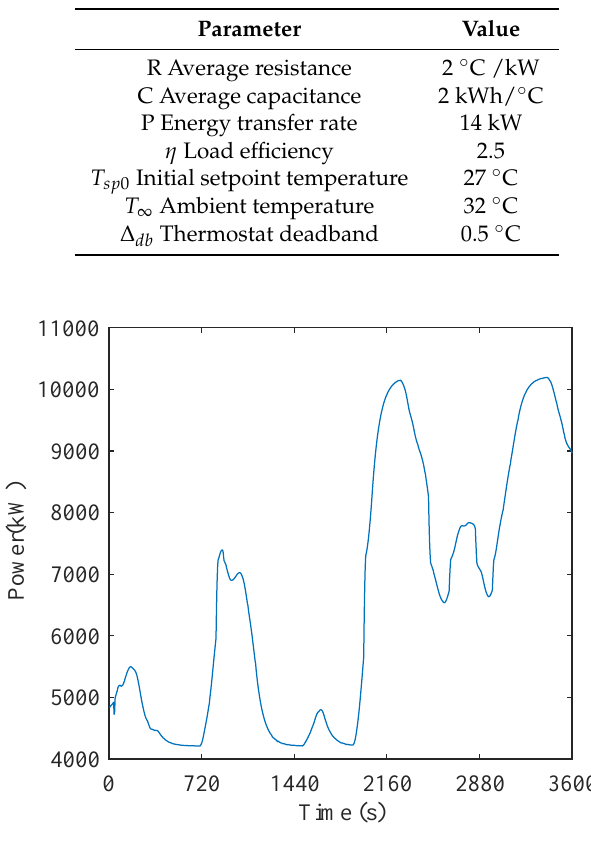
Figure 6. The change chart of automatic generation control (AGC) signals. Table 3. The value of